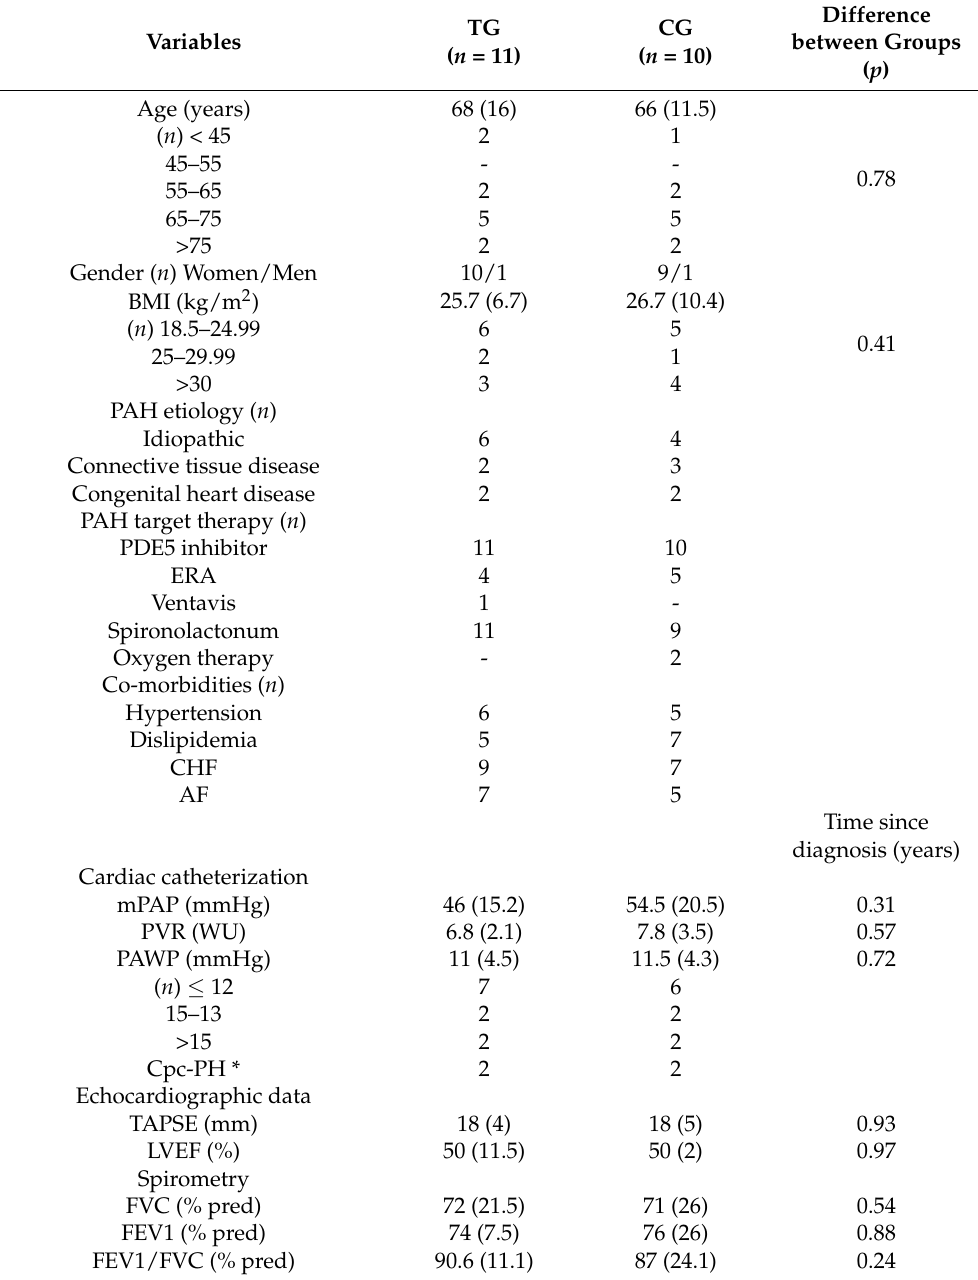
Table 1. Characteristics of